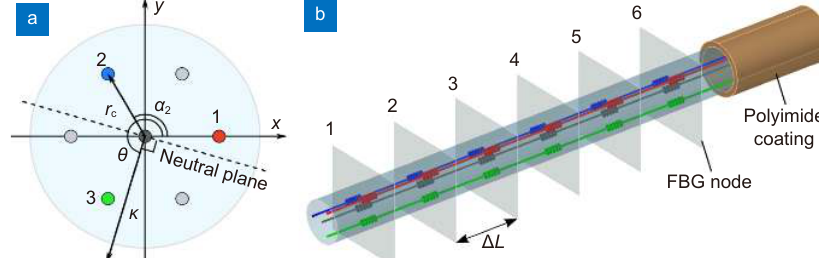
Fig. 7 | ( а ) MCF cross-section sketch, and relevant parameters for curvature calculation. ( b ) Schematic representation of the 3D FBG array writ- ten in a 7-core MCF through polyimide protective